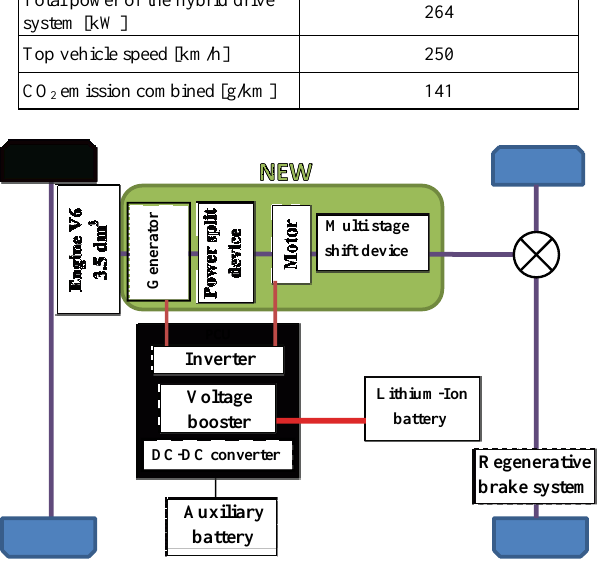
Fig. 2. Multi-Stage Hybrid System configuration [7]